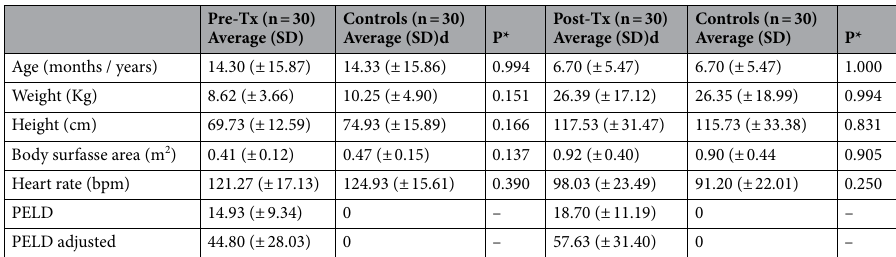
Table 1. Demographic parameters. PELD, Pediatric End-stage Liver Disease; *Students t-test.